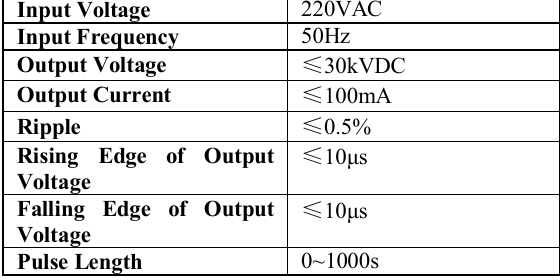
Table 2 . The parameters of the ASIPP anode power supply for #2 gyrotron and #3